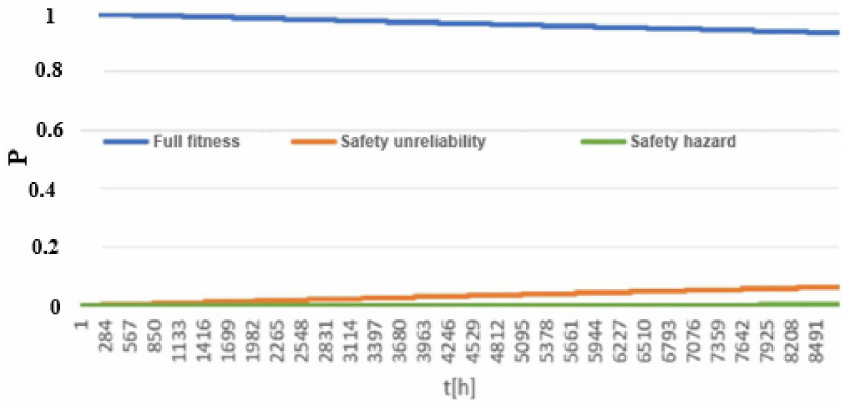
Figure 11. Probability functions for a system staying in one of the three primary states.